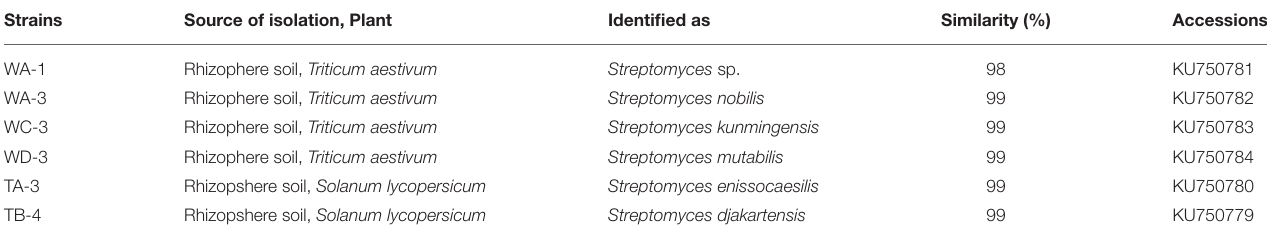
TABLE 5 | Genetic similarity of the selected strains with different species of the genus Streptomyces determined by 16S rRNA gene sequencing. Strains Source of isolation, Plant Identified as Similarity (%) WA-1 Rhizophere soil, Triticum